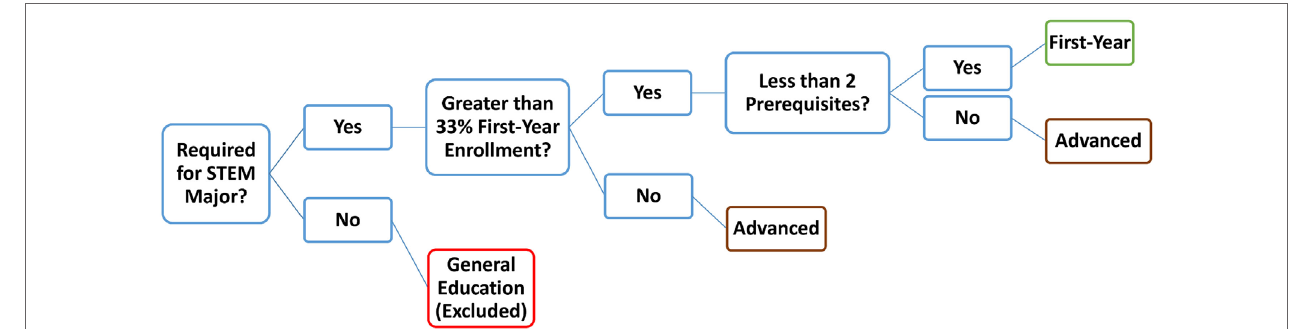
FigUre 2 | Sorting scheme used to determine the university course